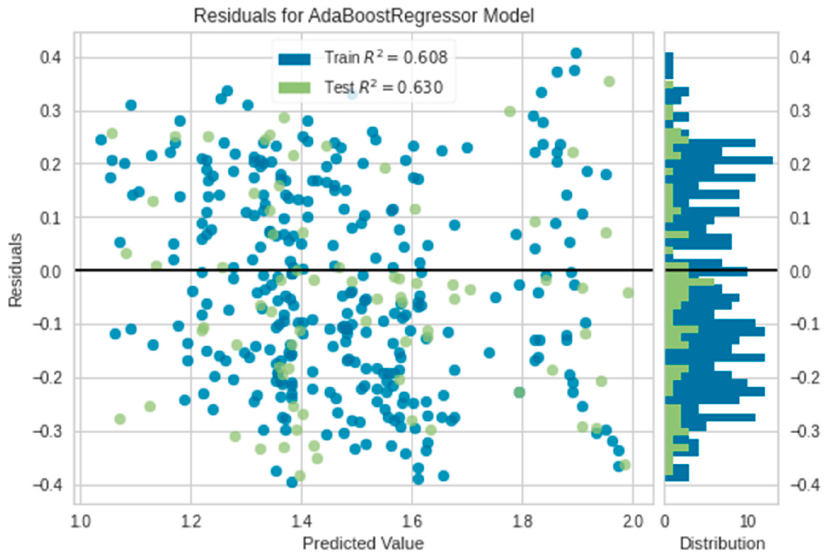
Figure 8. The residual plot of AdaBoost.